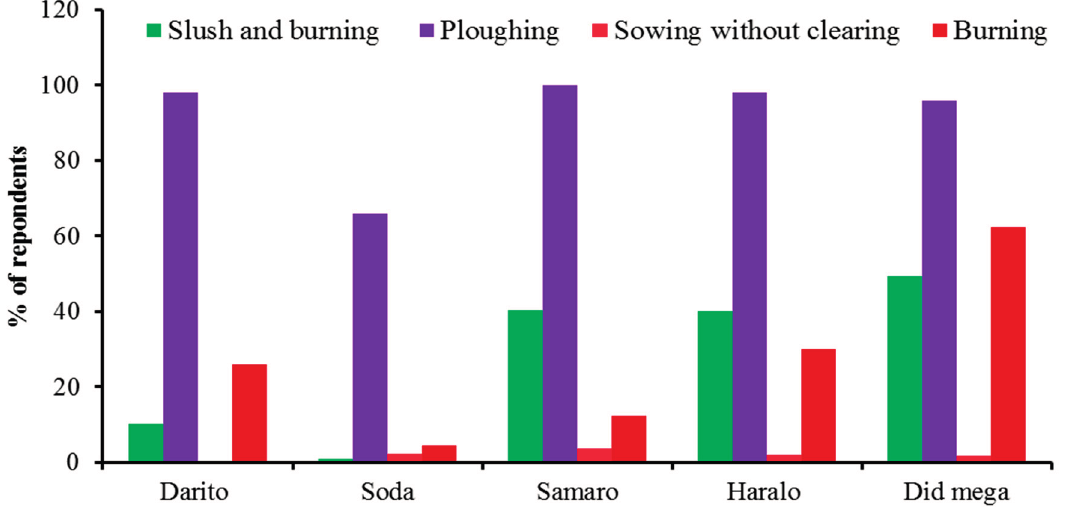
Figure 8. Land preparation under crop cultivation.